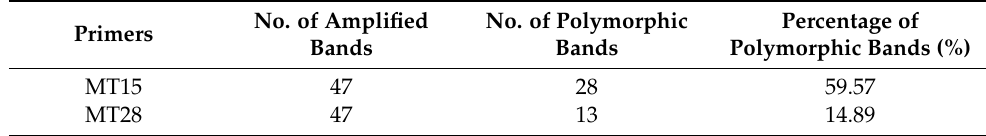
Table 5. Number of amplified bands, number of polymorphic bands, and percentage of polymorphic bands between the wild parent and the